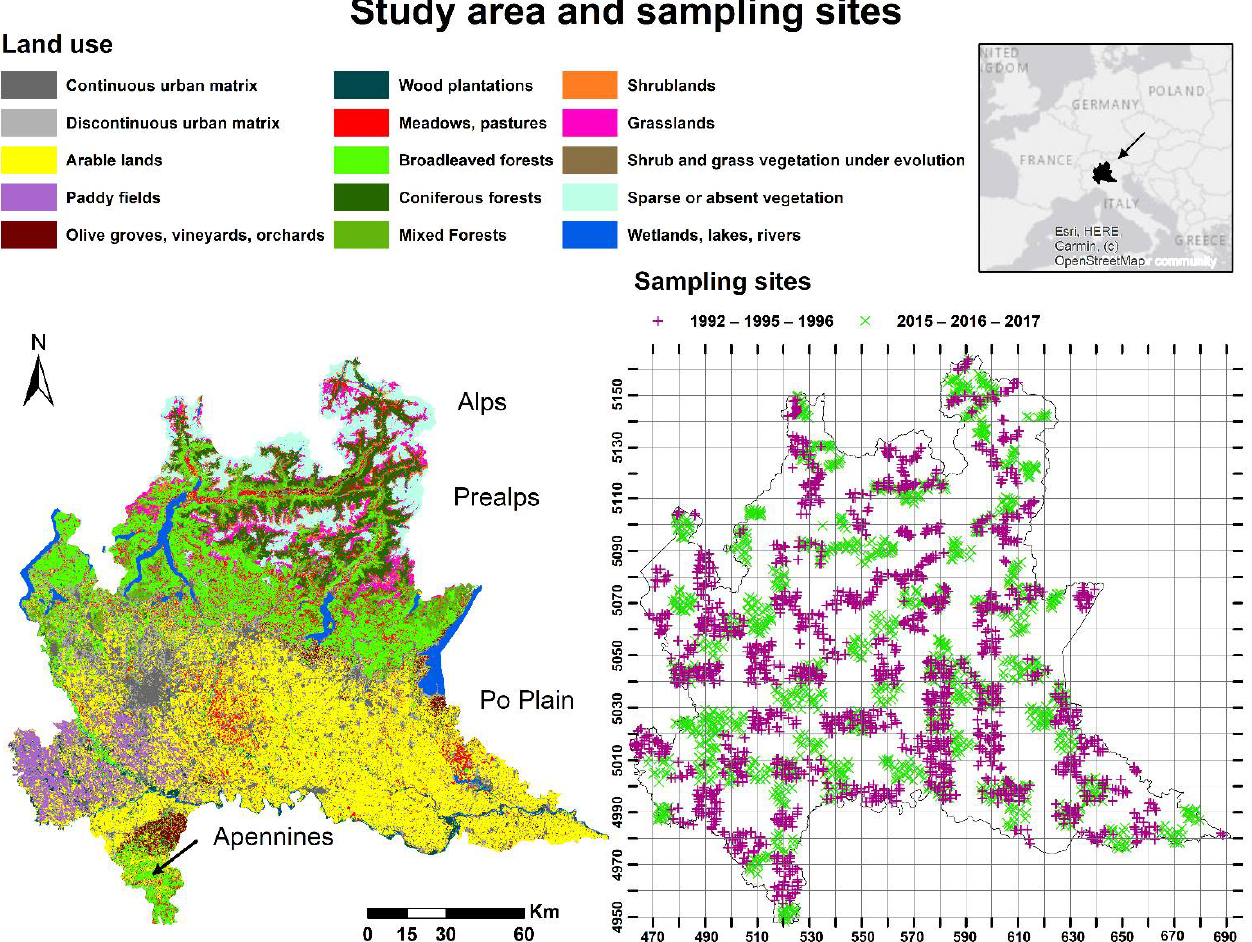
Figure 1. Main land covers in the study area and locations of the sampling sites. Land covers are represented according to 3rd-level of DUSAF land-cover map [59] with some mergers (see Table S1). 10-km square grid (WGS84, UTM 32N) is superimposed on sampling sites. X and Y coordinates are in km.